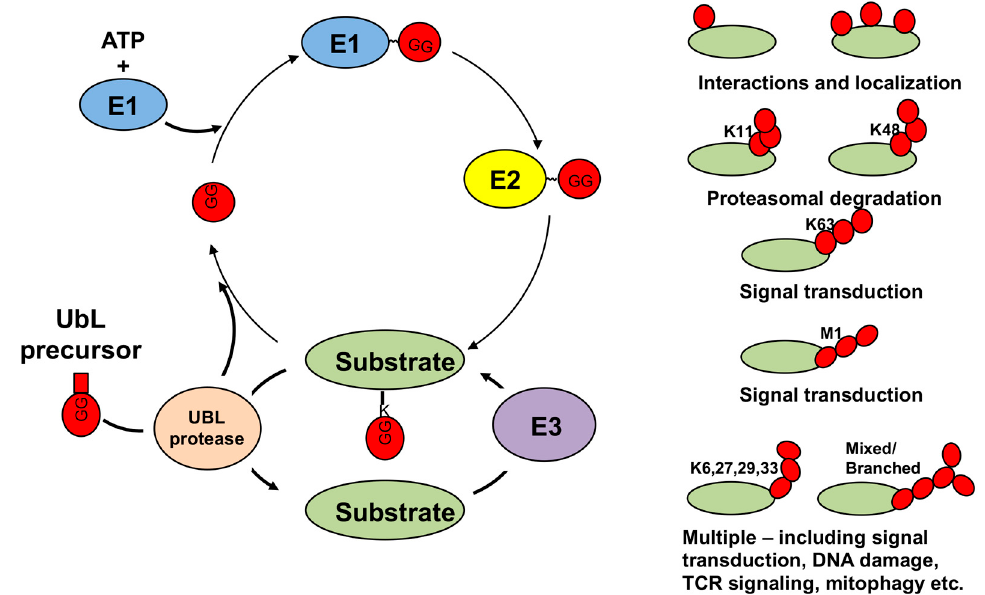
Figure 1 . Schematic illustration of the UbL activation, conjugation and deconjugation cycle. The